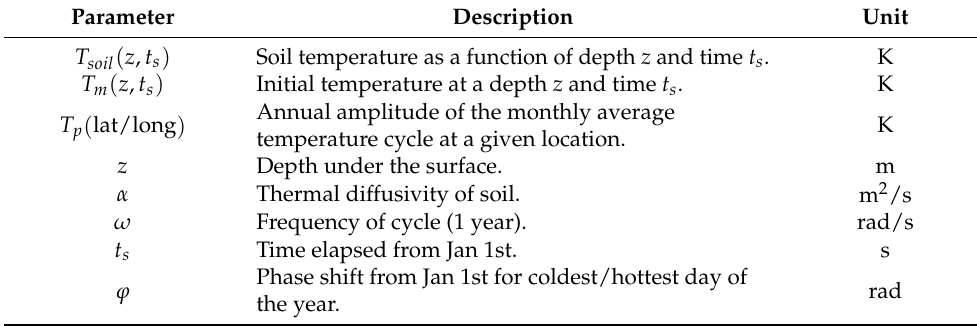
Table 2. Parameter description for heat equation in the underground